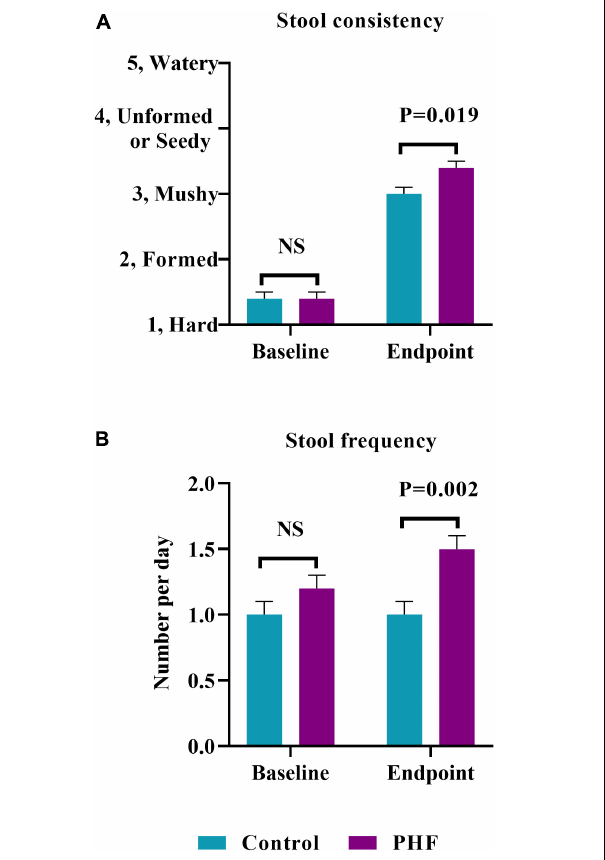
FIGURE 2 | (A) Stool consistency (mean ± SE) at Study Baseline and Endpoint. Parent-reported stool consistency was scaled as: hard, 1; formed, 2; mushy, 3; unformed or seedy, 4; watery and (B) stool frequency (mean ± SE) at Baseline and Endpoint which was parent-reported as